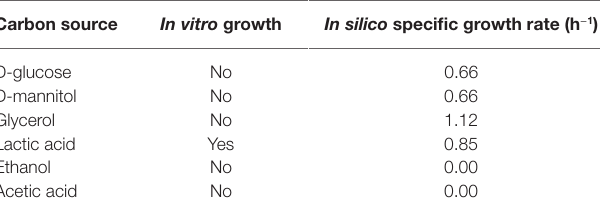
TABLE 1 | In vitro growth experiments and in silico predicted specific growth rate using different carbon sources. Carbon